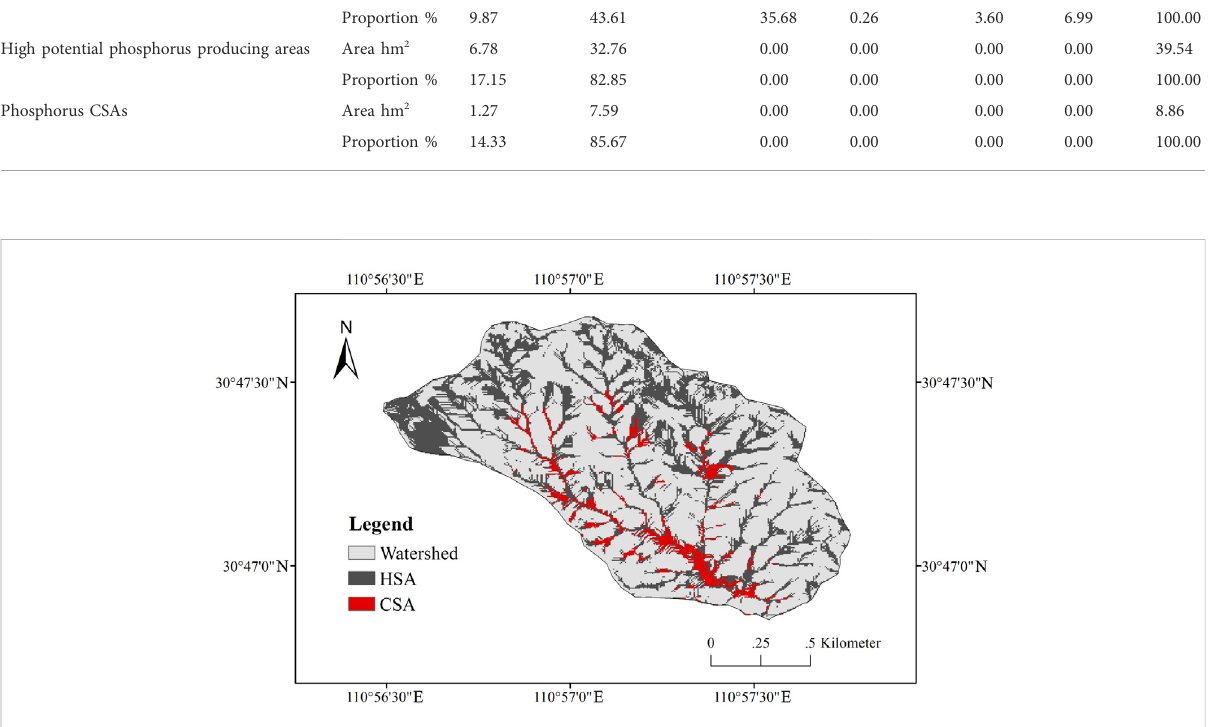
FIGURE 5 Phosphorus Critical Source Areas in Zhangjiachong